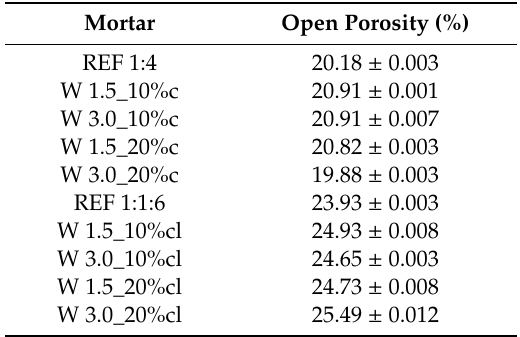
Table 7. Open porosity test results of the hardened mortars.